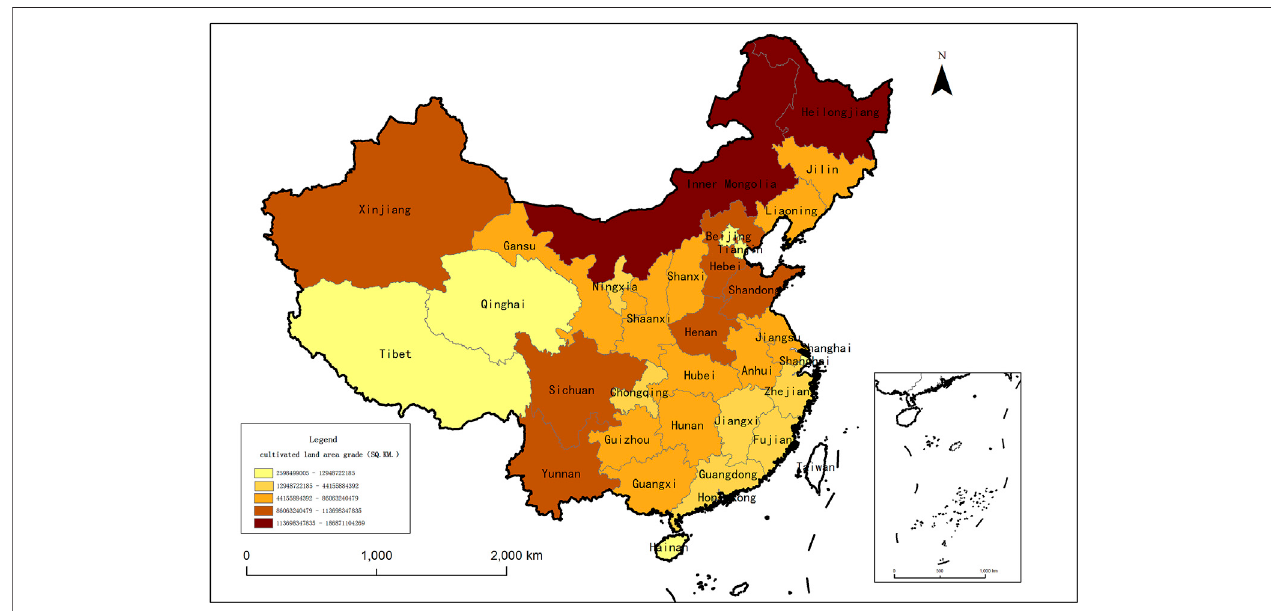
FIGURE 3 | The classi fi cation map of cultivated land area of China in 2020.